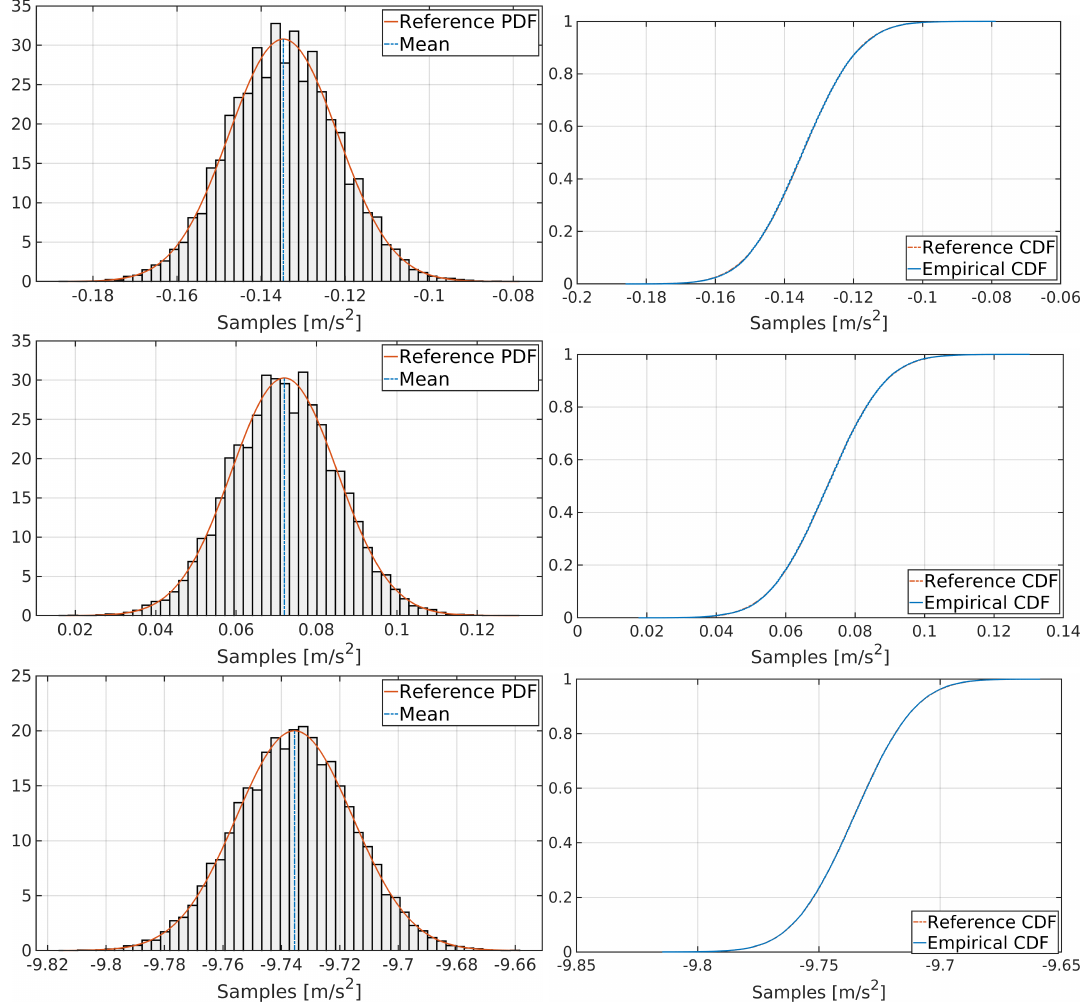
Figure 5. Graphical analysis of normal distribution for X, Y and Z MPU-6000 accelerometers,